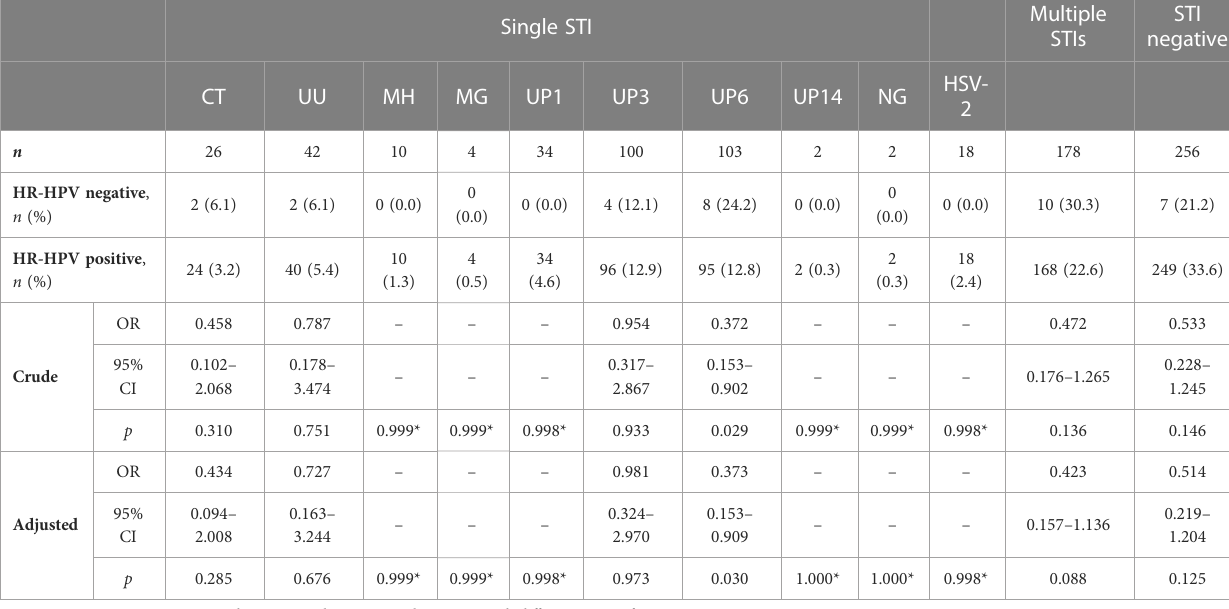
cervical biopsy results after adjusting for HPV infection status among the 749 individuals referred for colposcopy. There was not a signi fi cant between-cervical biopsy group difference in either total STI pathogen rate or individual STI pathogen rates after adjusting for HPV infection status (Table 6). TABLE 2 Infection rates of STIs in groups with or without HR-HPV infection among HPV-positive subjects.